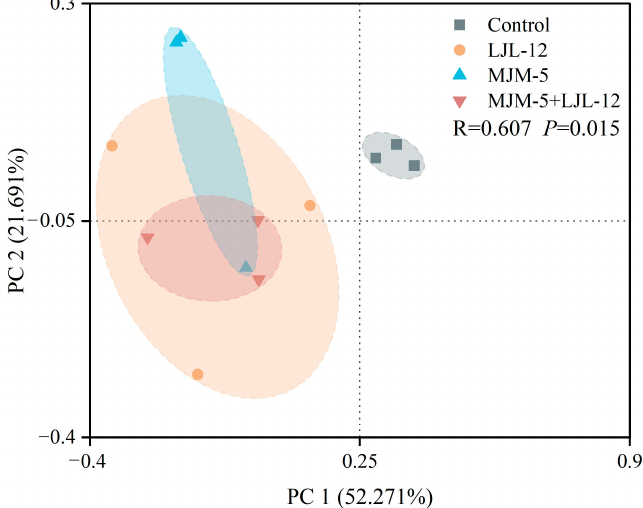
Figure 4. Beta-diversity of soil bacterial community in the rhizosphere of alfalfa under Control, LJL-12, MJM-5, and MJM-5+LJL-12 treatments. The two-dimensional ranking of the PCoA was based on the Abund–Jaccard analysis. The R and p values based on ADONIS indicate significant differences in bacterial community composition between the treatments.